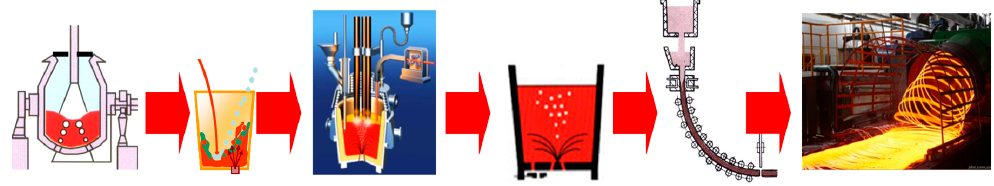
Figure 1. Production process of high-strength tire cord steel.